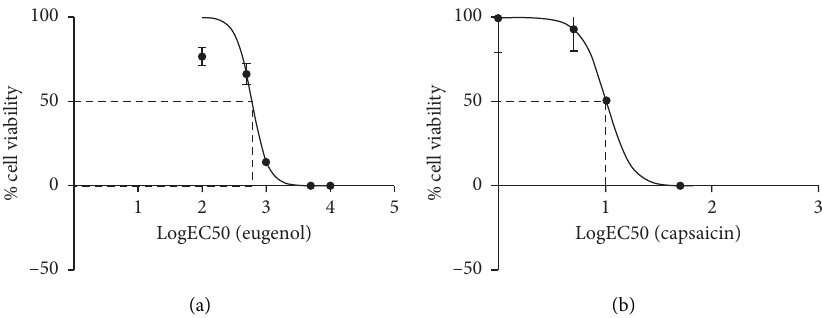
Figure 5: Calculation of EUG and CAP EC50 in hOLCs using resazurin technique. The EC50 was calculated from the resazurin assay in hOLCs exposed to different concentrations of the two compounds. (a) EUG EC50. Concentration range:10, 5, 1, 0.5, and 0.1mM. LogEC50: 2.781, equivalent to 603.5 μ M. (b) CAP EC50. Concentration range: 50, 10, 5, 1, and 0.5mM. LogEC50:1.004, equivalent to 10.1 μ M. GraphPad Prism 7.00 software was used. The curves represent the results of 3 independent experiments with six replicates each ( n �